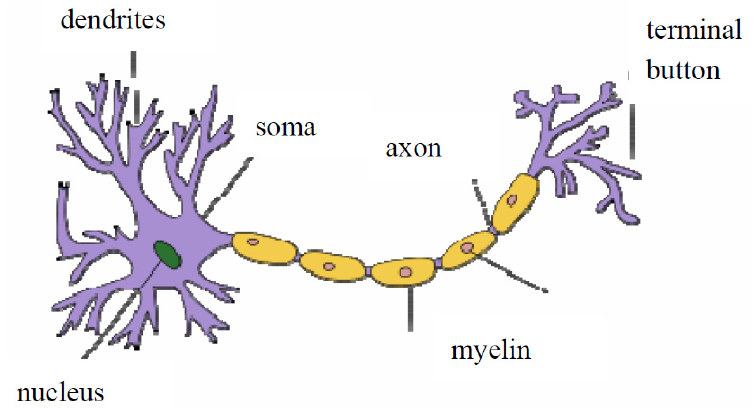
Figure 1. Schematic representation of biological neuron.